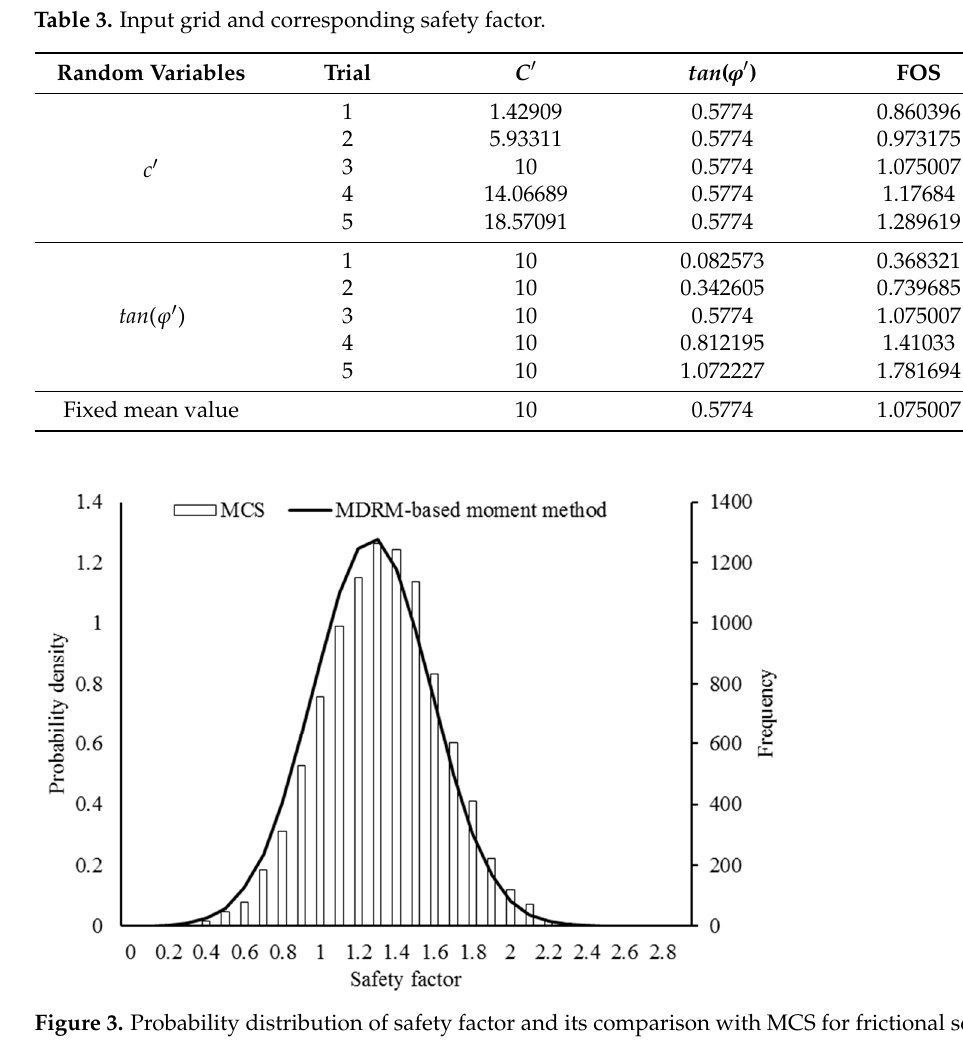
Table 3. Input grid and corresponding safety factor.